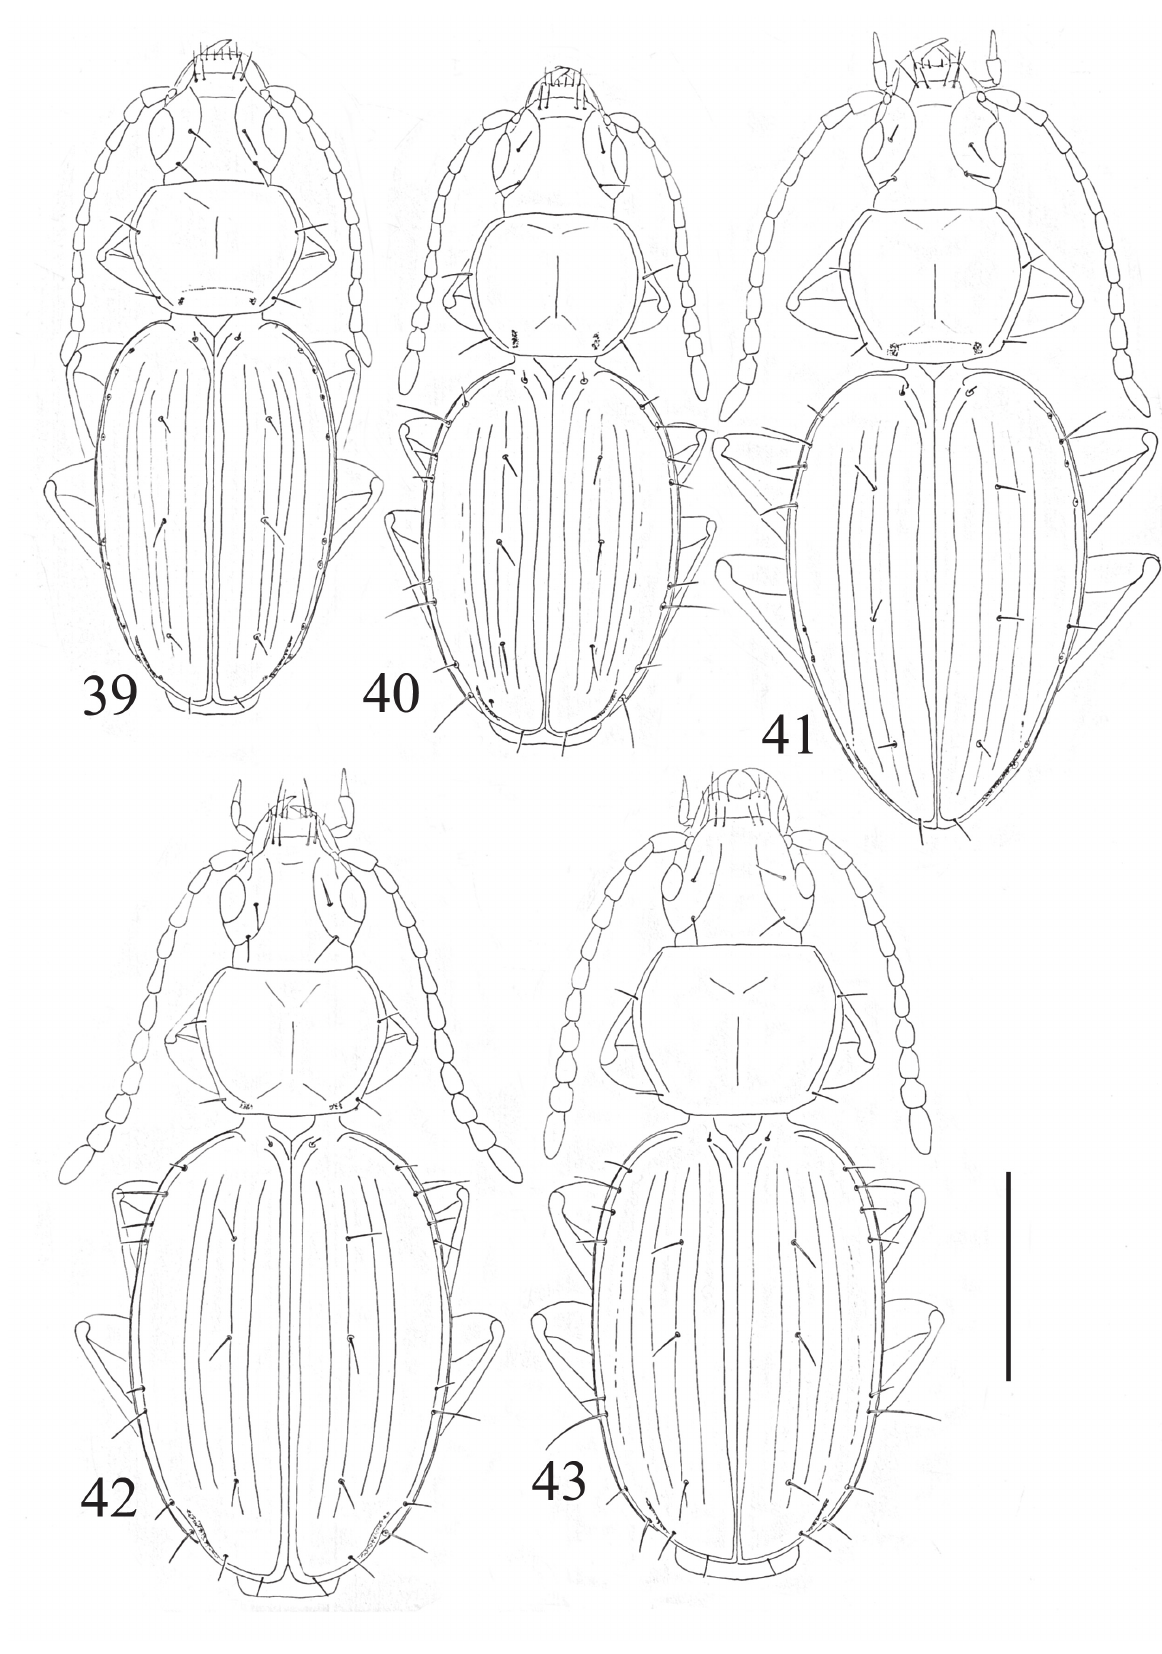
Figs 39-43. Habitus of Tasmanorites spp.: 39) T. tasmaniae (Blackburn) CT ♂, from Tasmania; 40) T. daccordii sp. nov., HT ♂ from Cradle Plateau; 41) T. blackburni (Sloane), LT ♂ from Cradle Mtn.(specimen with apex of the elytra deformed and laterally com- pressed); 42) T. glaebarum Moore, ♂ from Mt. Field; 43) T. intermedius Moore, ♂ from Mt. Field. Scale: 0.1